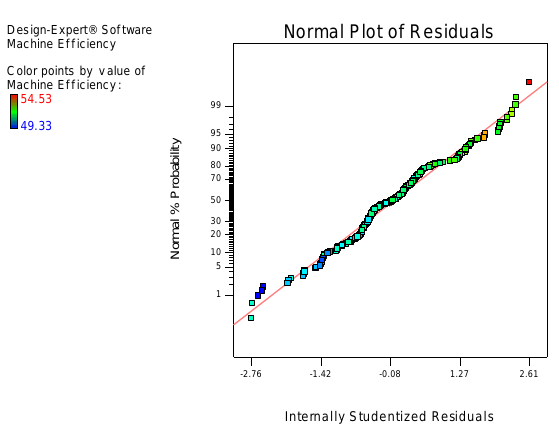
Design-Expert® Software Machine